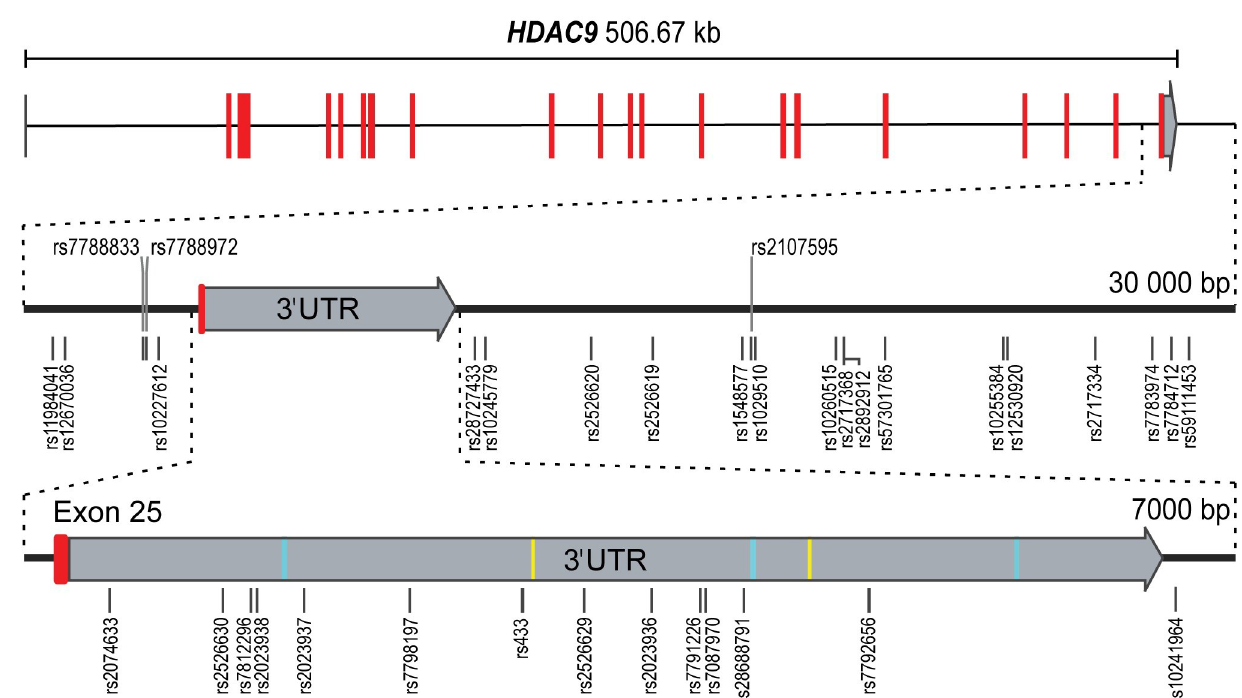
Fig 3. Genomic location of GWAS SNPs in the HDAC9 -associated CAD risk locus. GWAS SNPs associated with the risk of CAD as shown in Table 1 are located within a 28,399 bp region on chromosome 7 encompassing the final intron and coding exon of HDAC9 and the intergenic region between HDAC9 and TWIST1 . Red bars indicate protein coding exons, grey the 3’UTR of HDAC9 . Predicted 3’UTR motifs are indicated by cyan bars (UNR binding site) and yellow bars (K-box). 3’UTR and SNP locations are drawn to scale, red-colored coding exons are enlarged for ease of viewing.